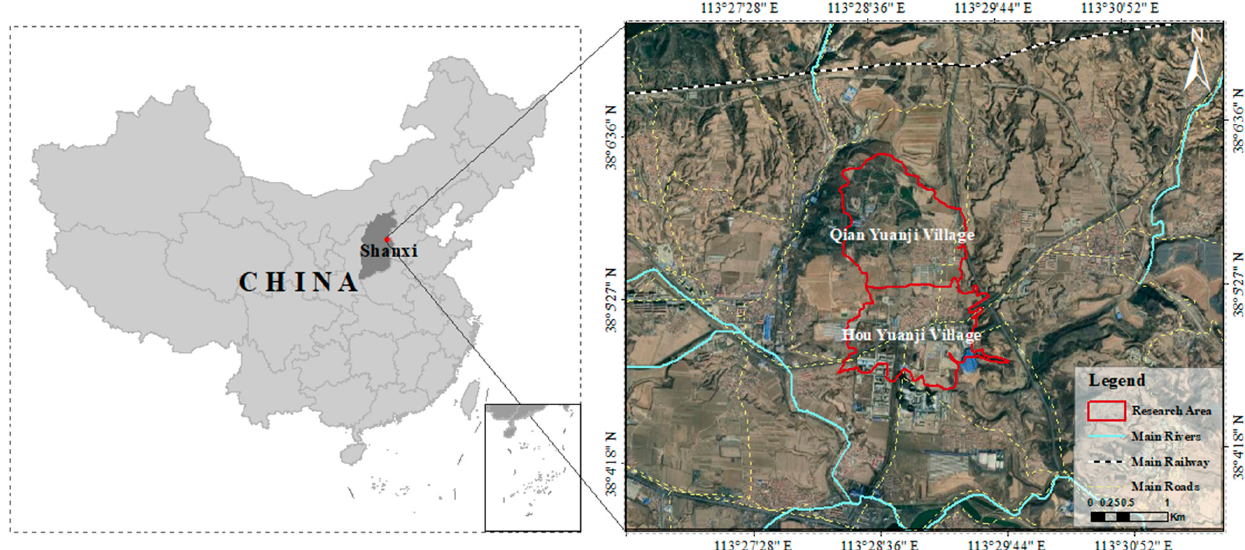
Figure 1. Location of the Yuanji village in Shanxi Province, CHINA.